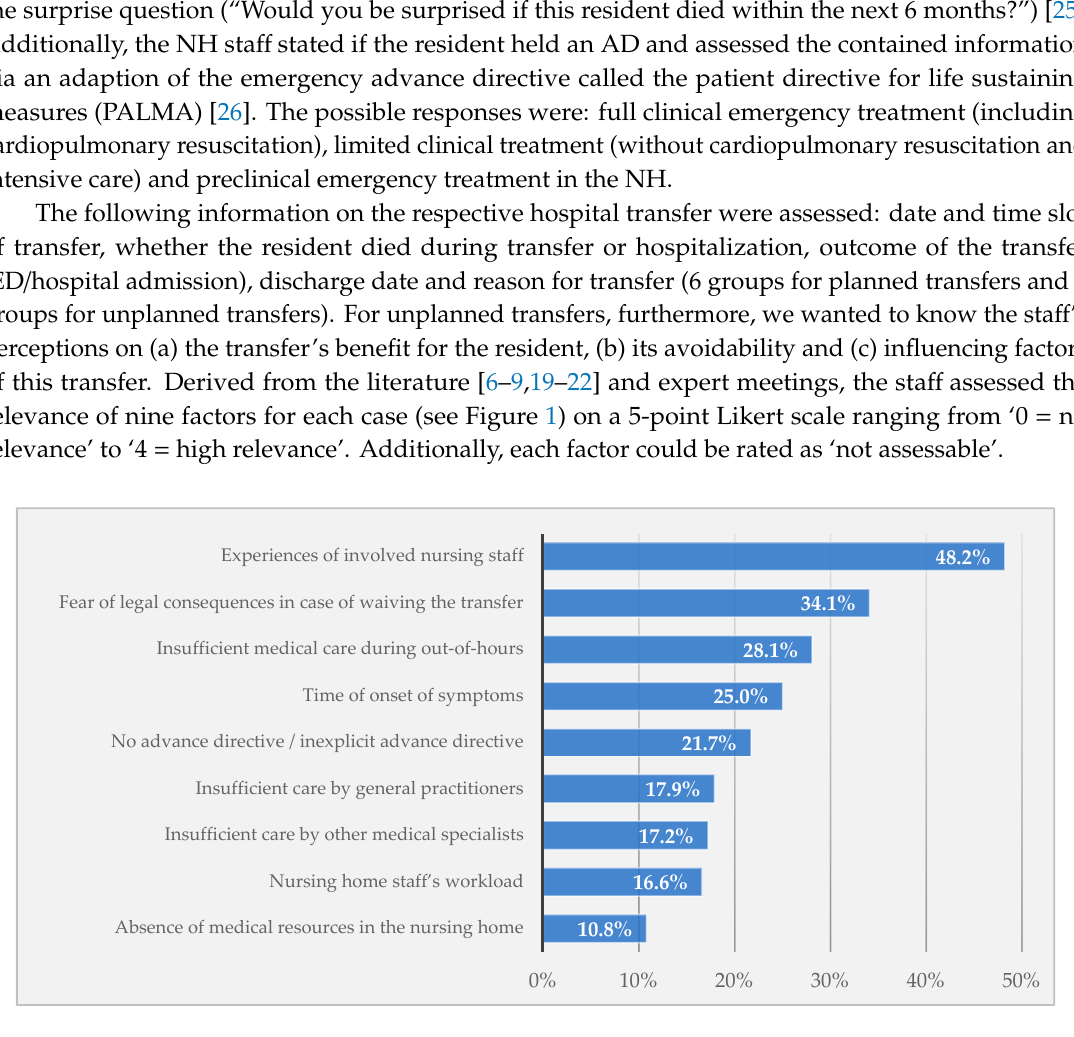
Figure 1. Influencing factors rated as “rather or very important” for unplanned hospital transfers by nursing home staff.